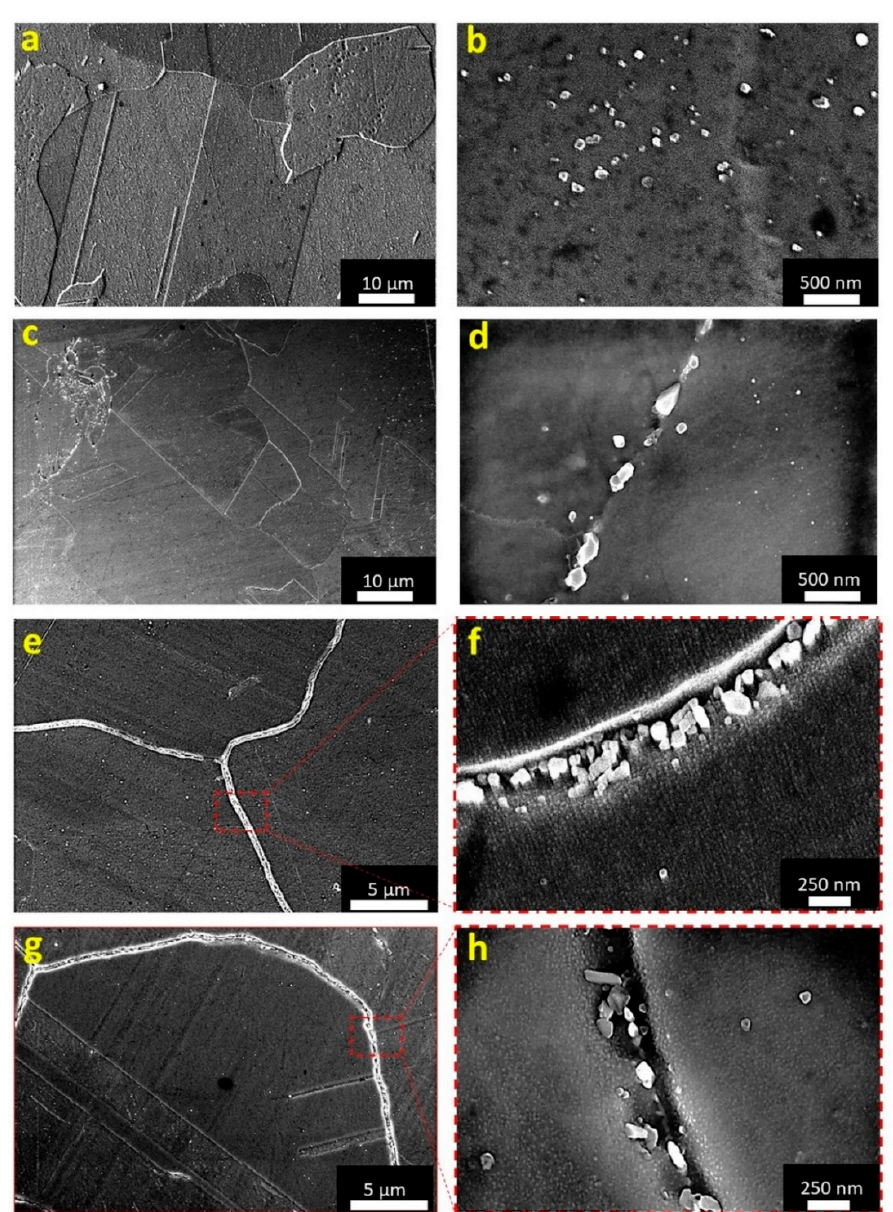
Figure 6. SEM images of the ST IN625 ( a , b ), ST IN625mod ( c , d ), STA IN625 ( e , f ), and STA IN625mod ( g , h ) showing the precipitates.